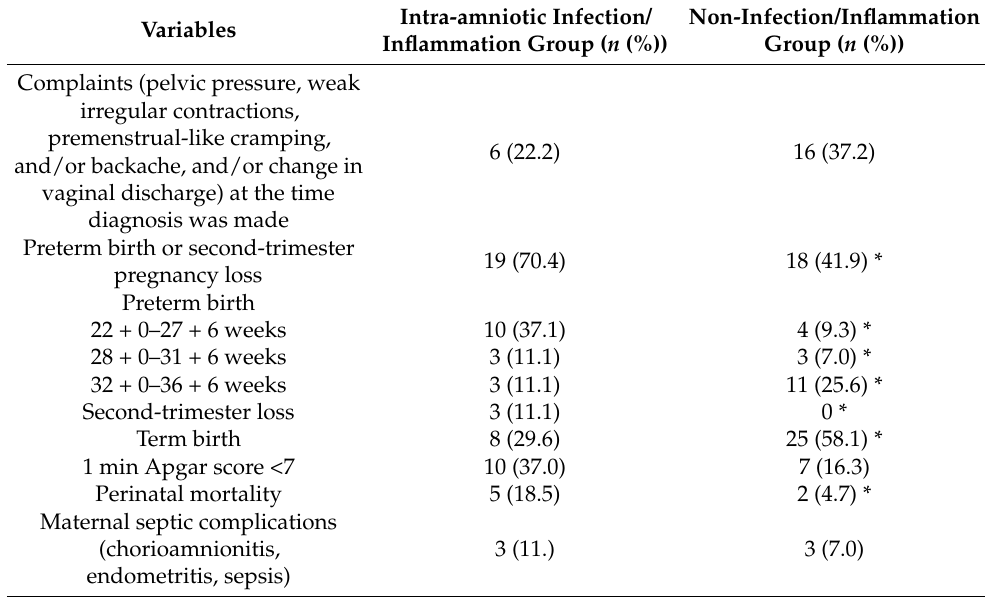
Table 2. The comparison of the intra-amniotic infection/inflammation and the non- infection/inflammation group. Intra-amniotic Infection/ Variables Inflammation Group ( n (%))